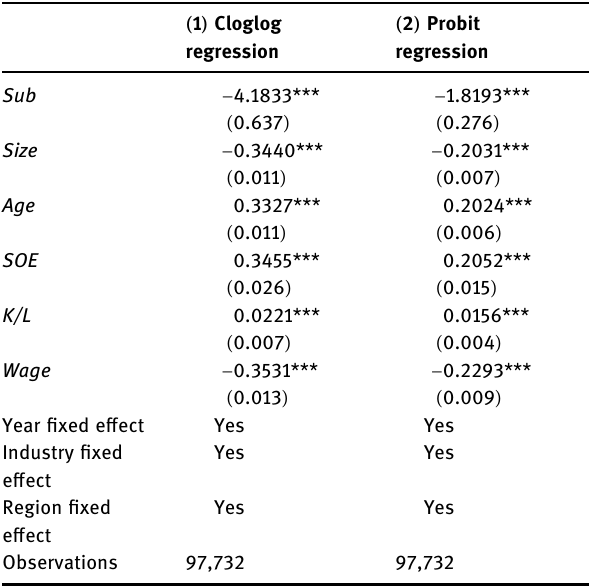
Table 4: Robustness check ( changing estimation method